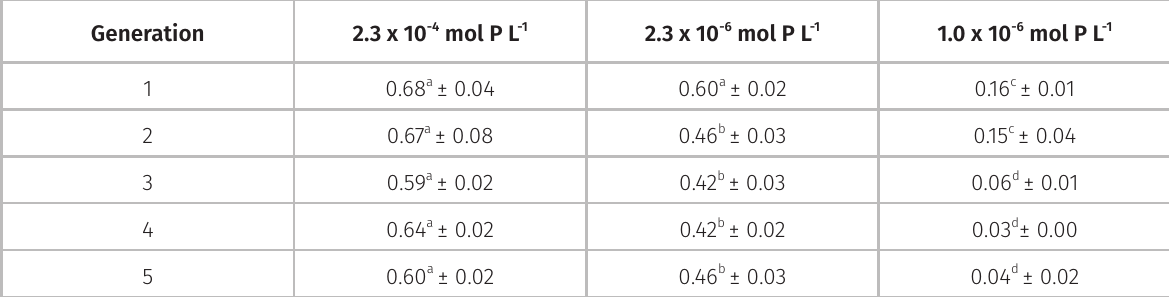
Table I. Mean growth rate values (days -1 ) for R. subcapitata in the acclimation experiments. Values with the same letters are not statistically different (Tukey’s Test, p>0.05). Values are means of three replicates (± Standard